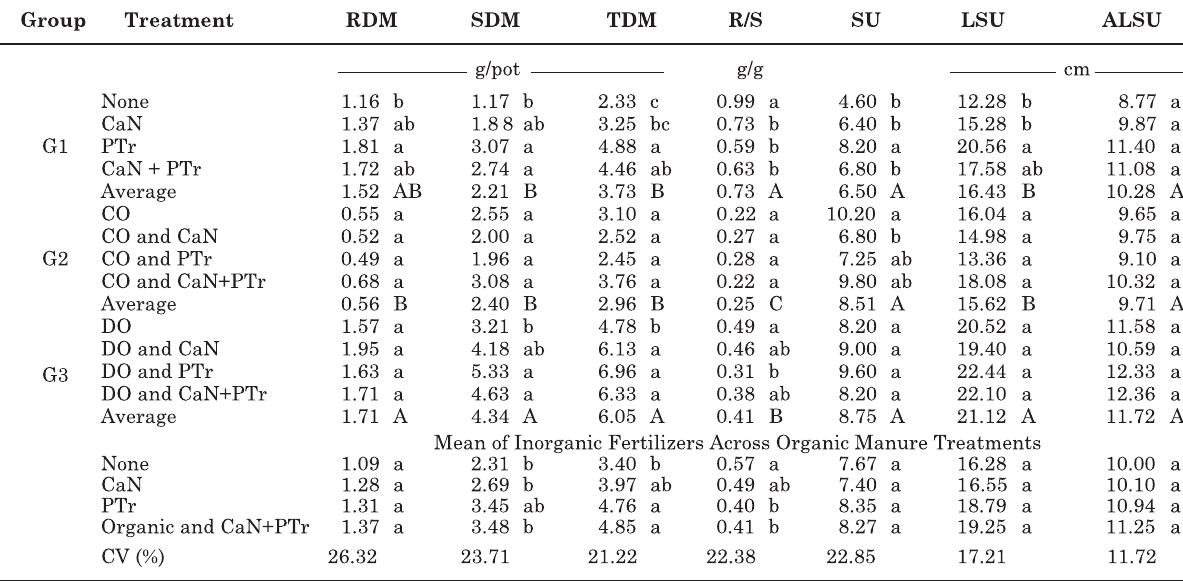
Table 3. Root dry matter production (RDM), shoot dry matter (SDM), total dry matter (TDM), ratio of root to shoot (R/S), number of shoot units (SU), length of the longest unit of the shoot (LSU) and average length of the shoot units (ALSU) in response to organic and mineral fertilizers and their